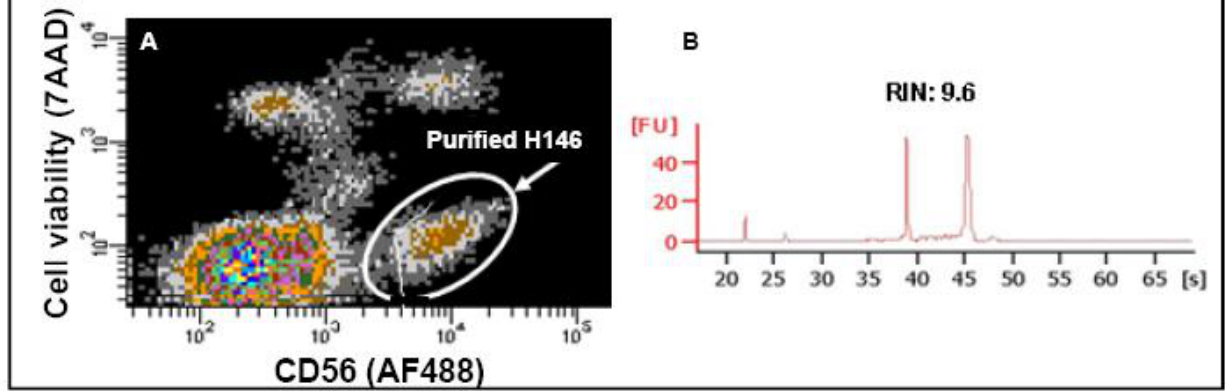
Figure 2. Feasibility evaluation of Tandem CellSearch-FACS for CTC purification. Spiked SCLC H146 cells were processed by the CellSearch system using CellSearch Profile kit. Panel A The recovered cells were stained with Alexa Fluor 488 conjugated CD56 antibody and 7-AAD before the sorting of viable CD56 positive cells by FACS. Panel B A quality check on extracted RNA from FACS sorted cells in panel A showed good quality of RNA with high RNA integrity number